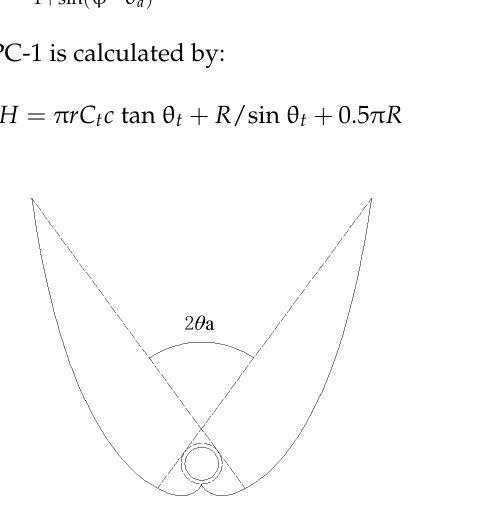
Figure 2. CPC ‐ 1, designed based on the cover tube of evacuated solar tube (EST).